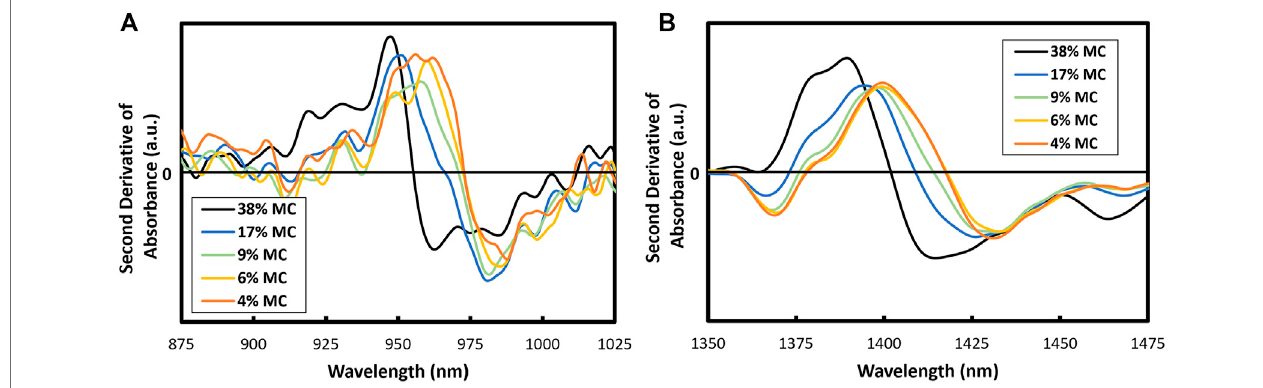
FIGURE 5 | Second derivative of NIR absorbance spectra for stalk pith in the range of the amorphous -OH groups at 970 nm (A) and 1,424 nm (B) equilibrated at varying % moisture content (MC).